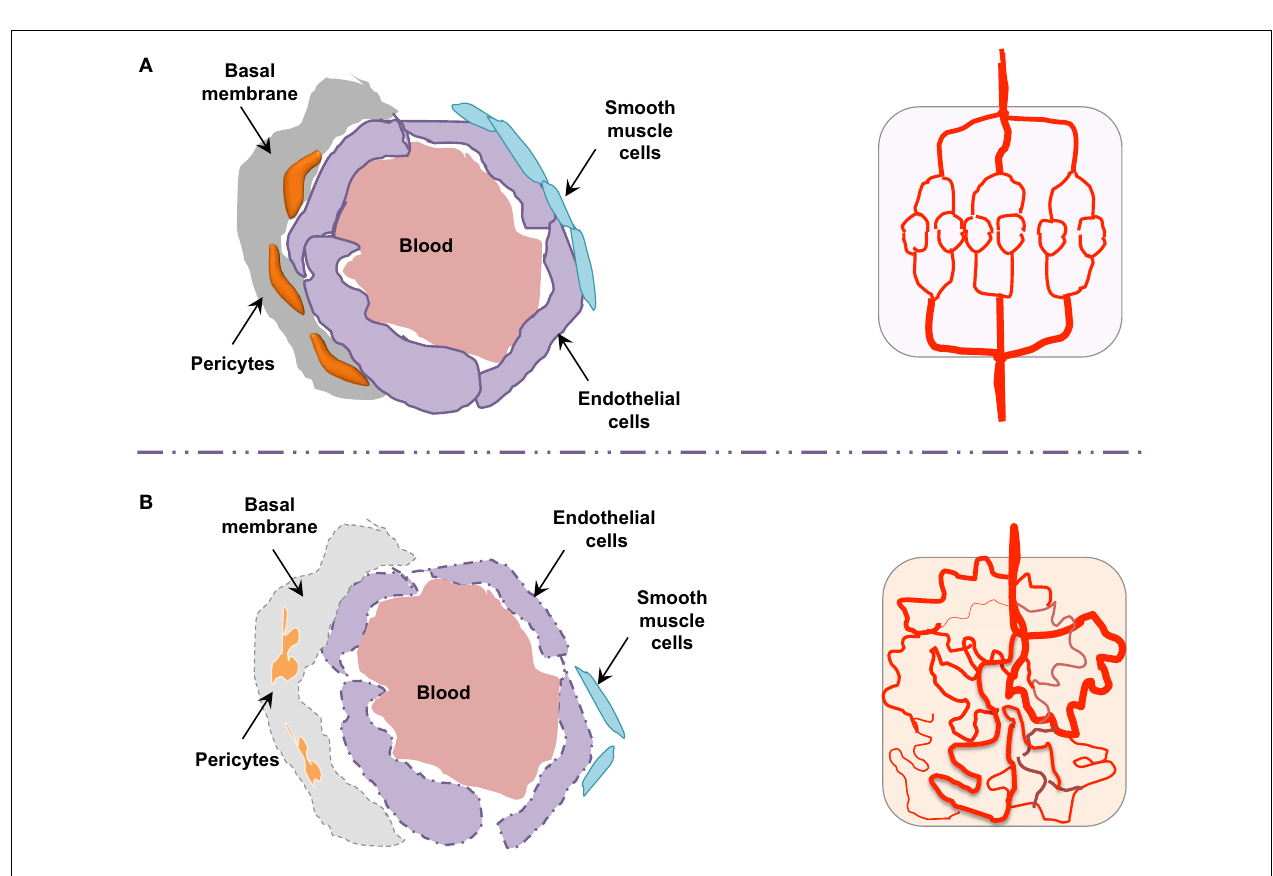
disorganized and anarchic, presents morphological and structural difference, i.e., weak association between endothelial cells, abnormal shapes of pericytes, lack of smooth muscles, as well as basal membrane